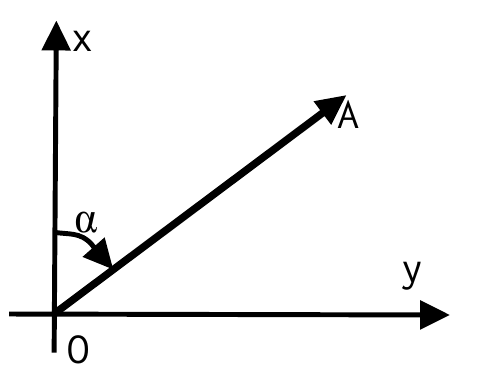
Fig.9 Definition of azimuth. Fig. 9. Definition of azimuth.